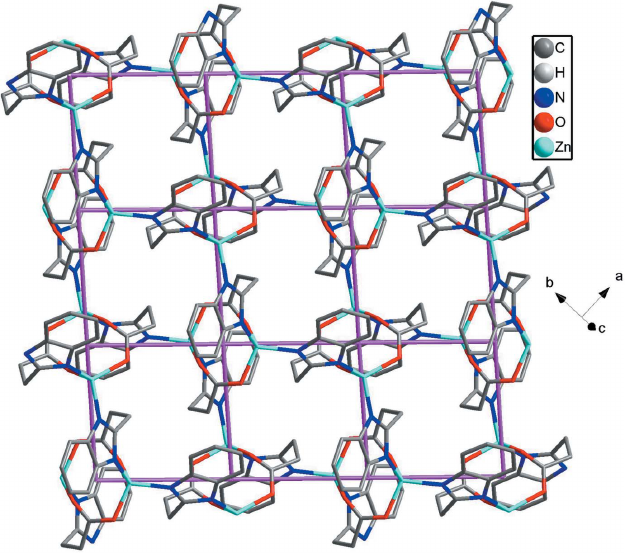
Figure 2 A perspective view of the 4-connected nodes in 1